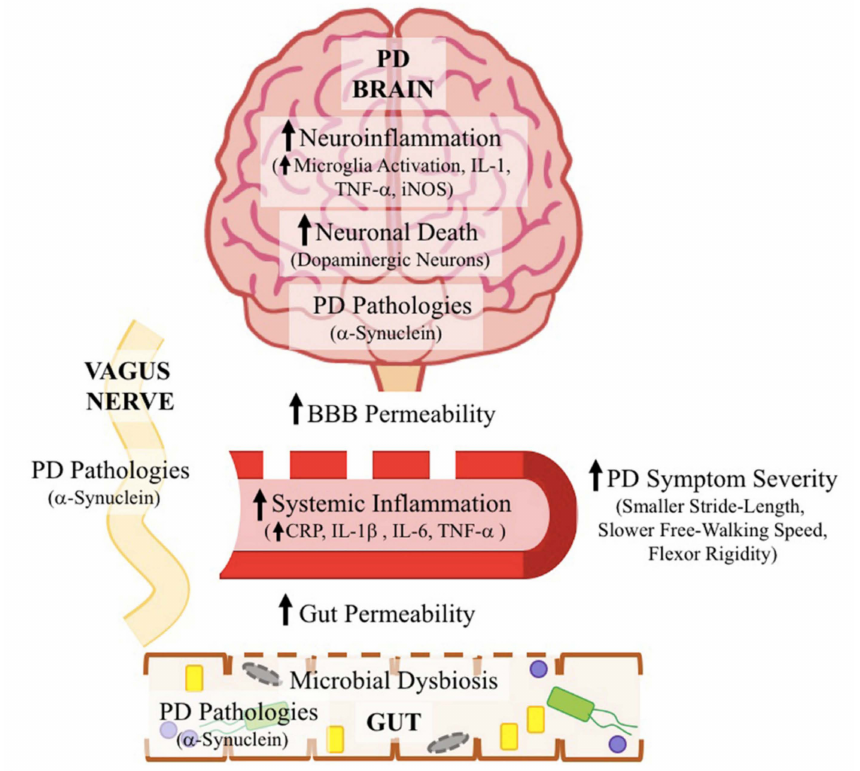
Figure 2. The role of gut microbiota in the pathogenesis of Parkinson’s disease. BBB, blood brain barrier; CRP, C-reactive protein; IL, interleukin; iNOS, inducible nitric oxide synthase; PD, Parkinson’s Disease; TNF, tumor necrosis factor [43] (reused with permission, license number: 4637571224608, Elsevier and Copyright Clearance